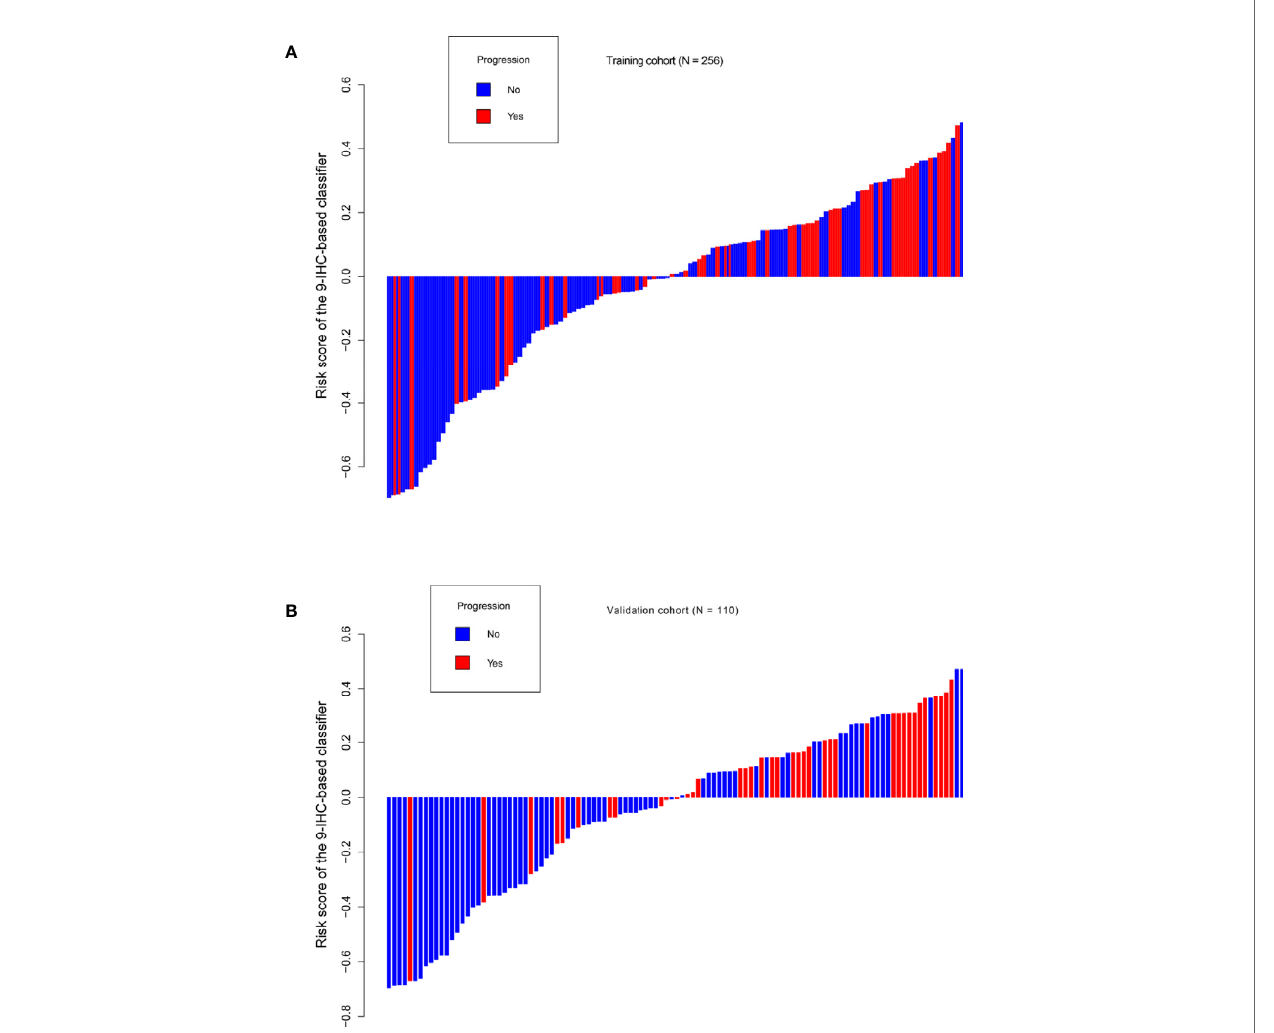
FIGURE 2 | Distribution of risk score based on 9-IHC-based classi fi er. (A) Training cohort. (B) Validation